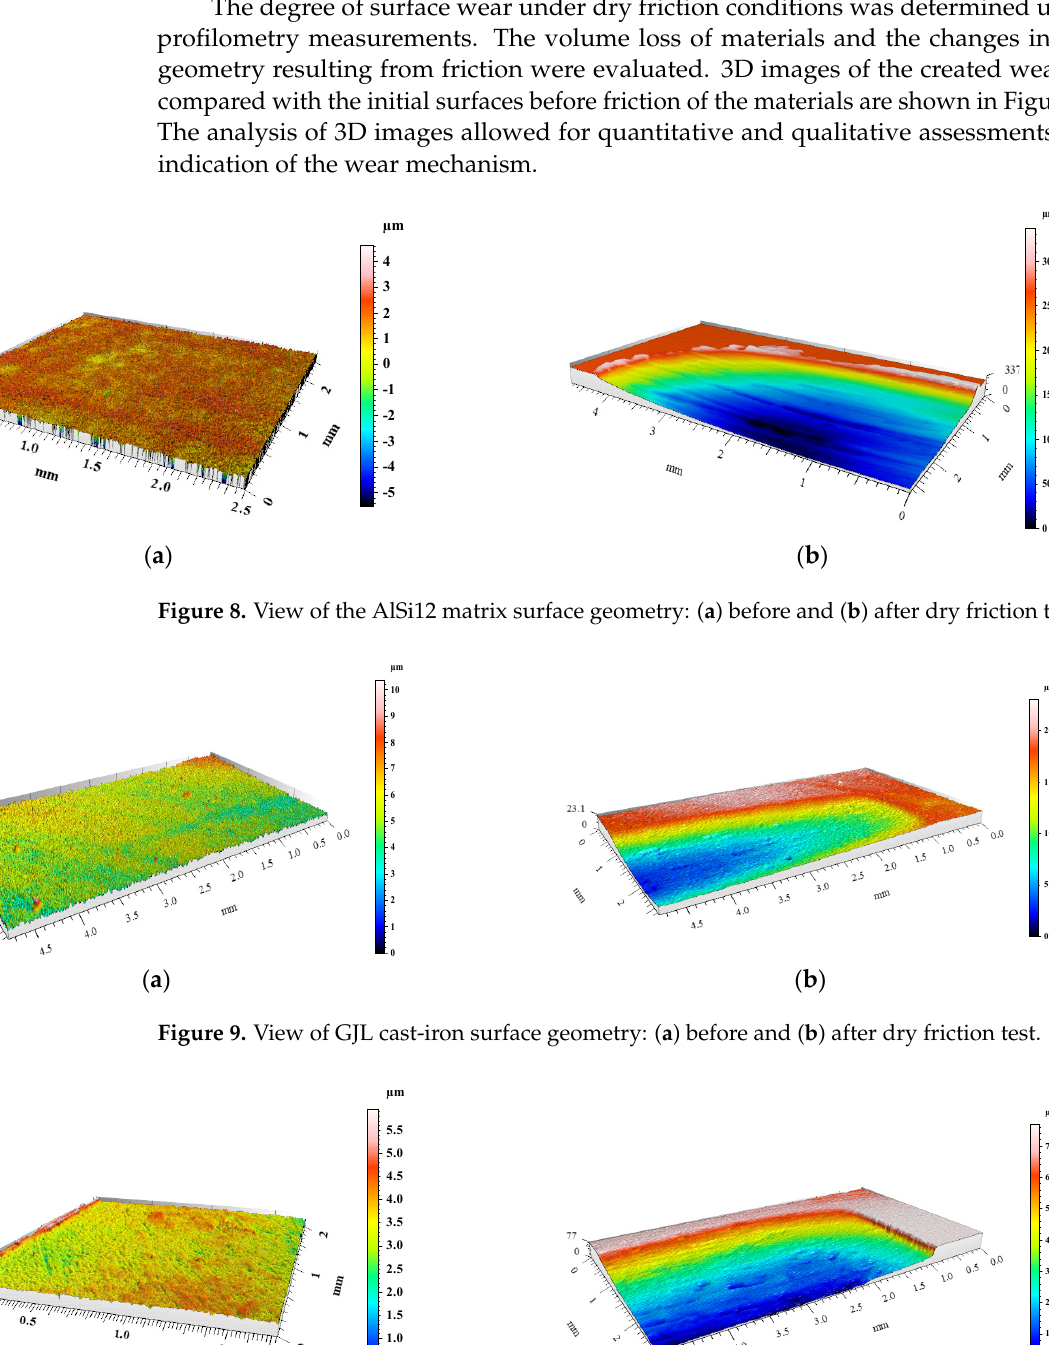
0.00.5 Figure 10. View of AlSi12/SiC p composite surface geometry: ( a ) before and ( b ) after dry friction test.